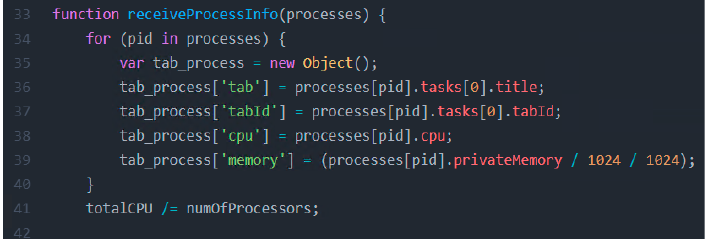
Figure 10. Obtain CPU usage and memory usage.